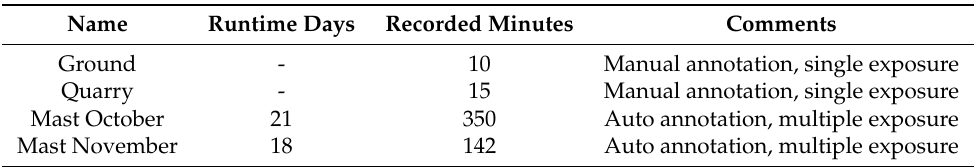
Table 3. Overview of the recording